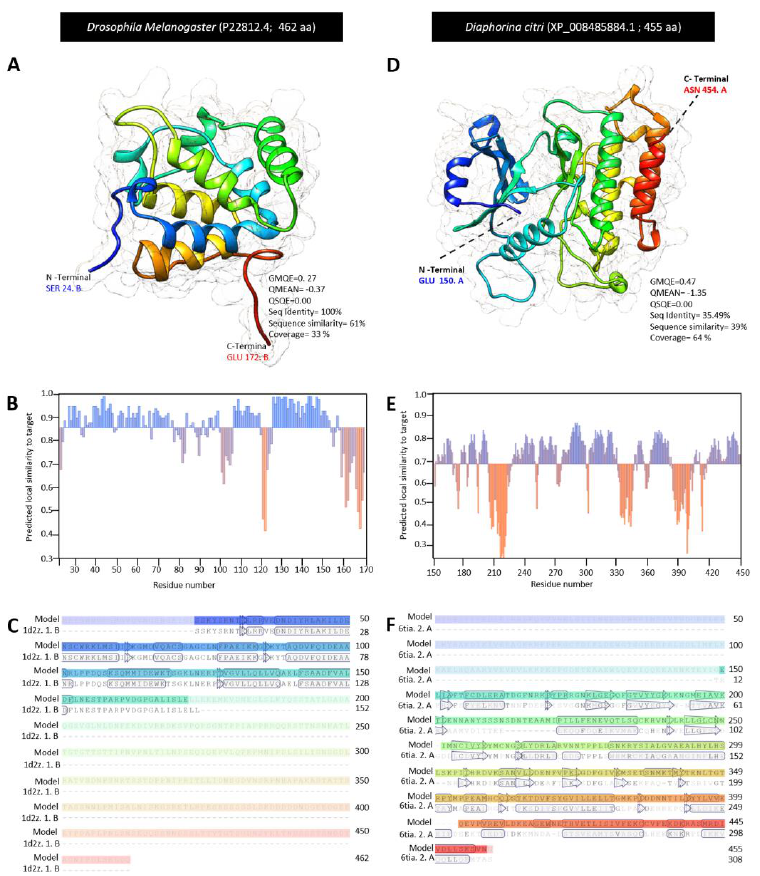
Figure 4. The crystallographic three-dimensional (3D) modeling of Tube protein of D. citri. ( A , D ) The predicted the three-dimensional (3D) structure model and its associated mesh surface of DmTube (P22812.4), and DcTube (XP_008485884.1), respectively. The tertiary structures of D. melanogaster and D. citri were predicted with the template of 3D structure of the complex between the death domains of Pelle and Tube (knows as the death domain of Tube) in the Protein Data Bank (PDP ID: 1d2z.1.B) with 2.00 Å resolution, and template of interleukin-1 receptor-associated kinase 4 (IRAK4 in complex with inhibitor) in the Protein Data Bank (PDP ID: 6tia.2.A) with 2.52 resolutions, re- spectively. Protein chains are colored according to the rainbow color spectrum from blue (N-terminal) to the red (C-terminal). ( B , E ) Model–template alignment of DmTube and DcTube, respectively. Amino acid sequences of D. melanogaster and D. citri template were aligned separately with 1d2z.1.B, and 6tia.2.A, respectively. The secondary structure of each model are presented by α -helices (rectangles) and β -pleated sheets (arrows). Matched sequences in alignment are presented in black. ( C , F ) Local quality estimate of the predicted models of DmTube, and DcTube, respectively. All bioinformatic analyzes were accomplished based on the most recent data available in GenBank, the National Cen- ter for Biotechnology Information website (NCBI, http://www.ncbi.nlm.nih.gov/gene/, accessed on 12 April 2021). The 3D structure of the protein was generated using the Swiss-model server (https://swissmodel.expasy.org/, accessed on 13 July 2021) and visualized with UCSF Chimera package (version 1.15) (https://www.cgl.ucsf.edu/chimera/, accessed on 13 July 2021). QSQE: qua- ternary structure quality estimate, GMQE: global model quality estimation, and QMEAN z-scores: qualitative model energy